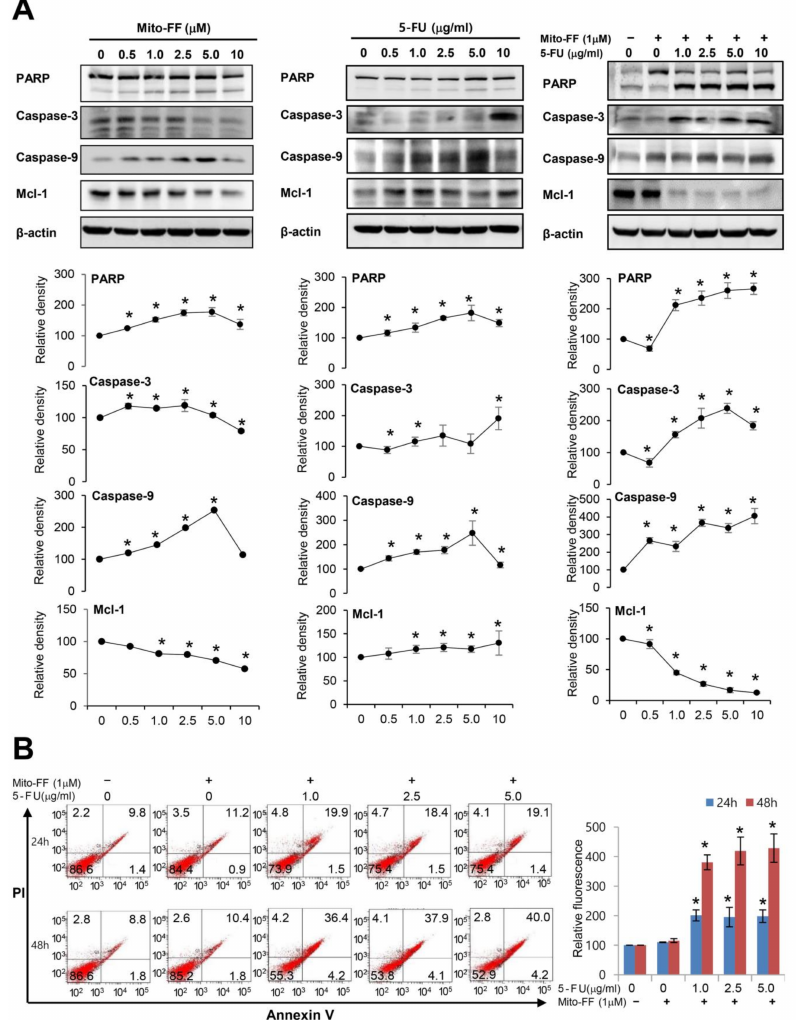
Figure 2. Cell apoptosis assay in gastric cancer cells. ( A ) Western blot analysis to determine the changes of pro-apoptotic (poly-ADP (adenosine diphosphate)-ribose polymerase (PARP), caspase-3, and caspase-9) and an anti-apoptotic (myeloid cell leukemia-1 (Mcl-1)) marker according to mono- and combination therapy using 5-FU and Mito-FF in adeonocarcinoma gastric (AGS) cells. In all treatments, as the concentrations were increased, pro-apoptotic markers increased, whereas anti-apoptotic markers decreased. These trends were most prominent in combination therapy. ( B ) Determination of apoptosis by flow cytometric analysis of Annexin V / propidium iodide staining [Left]. The proportion of apoptosis is determined by the total fraction of Annexin V-positive cells (the combination of early and late apoptotic cells). [Right] Relative percentages of apoptotic cells following each treatment. The number of Annexin V-positive cells was significantly increased following combining mito-FF with increasing concentration of 5-FU, especially 48 h after treatment. Values are presented as mean ± standard deviation of three independent experiments. * P <